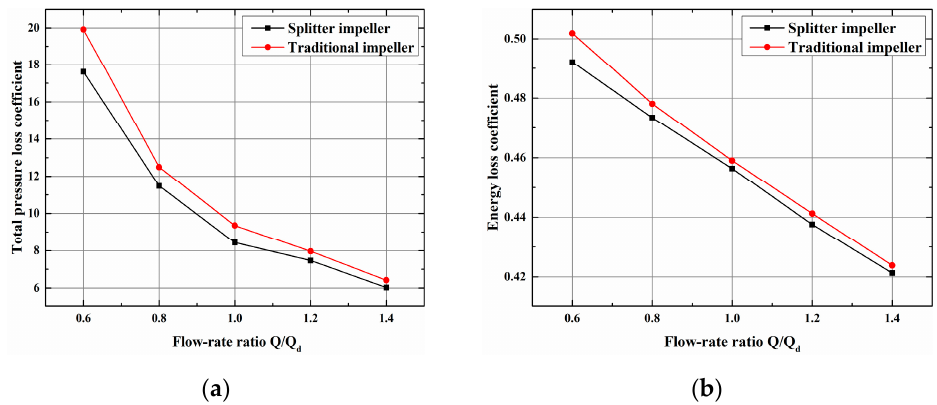
Figure 17. Performance comparison curve between the splitter impeller SP15 and the traditional impeller: ( a ) Curve of total pressure loss coefficient; ( b ) curve energy loss coefficient.